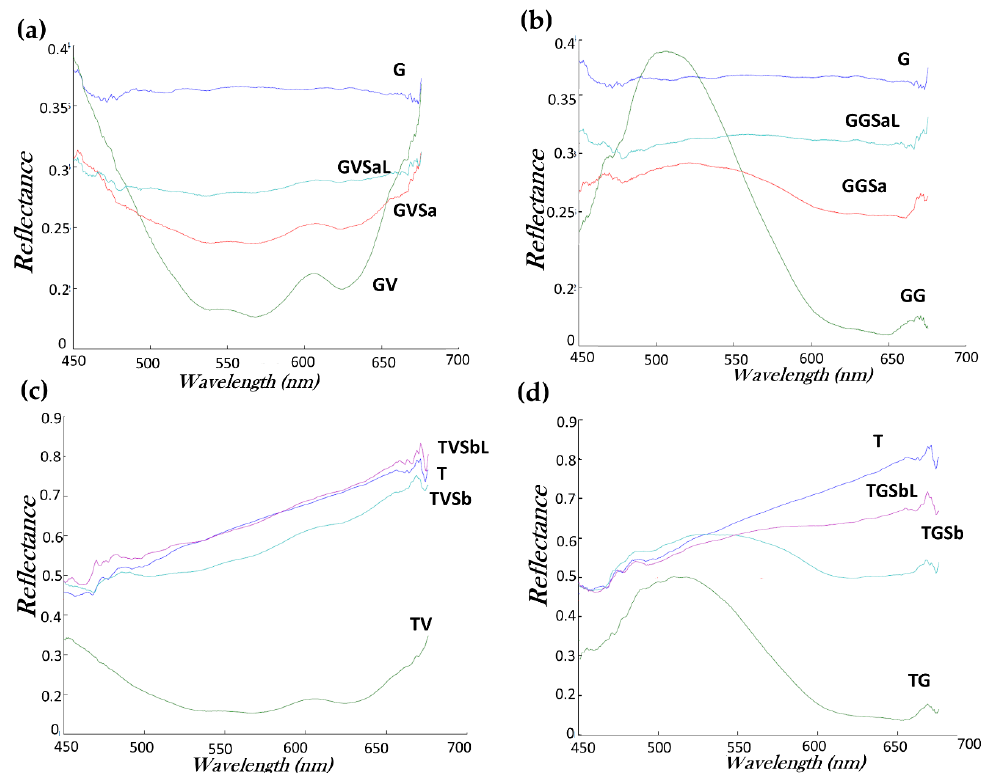
Figure 6. Reflectance spectra of the treated surfaces (gneiss and travertine) after the application of the cleaning procedures tested to remove violet and green paints. For comparative purposes, the reflectance spectra of the painted (GV: gneiss with violet paint; GG: gneiss with green paint; TV: travertine with violet paint; TG: travertine with green paint), and unpainted stones (G: gneiss; T: travertine) are also shown. ( a ) Reflectance spectra of the gneiss painted with violet graffiti. ( b ) Reflectance spectra of the gneiss painted with green graffiti. ( c ) Reflectance spectra of the travertine painted with violet graffiti. ( d ) Reflectance spectra of the travertine painted with green graffiti. Check Table 3 for sample labels.